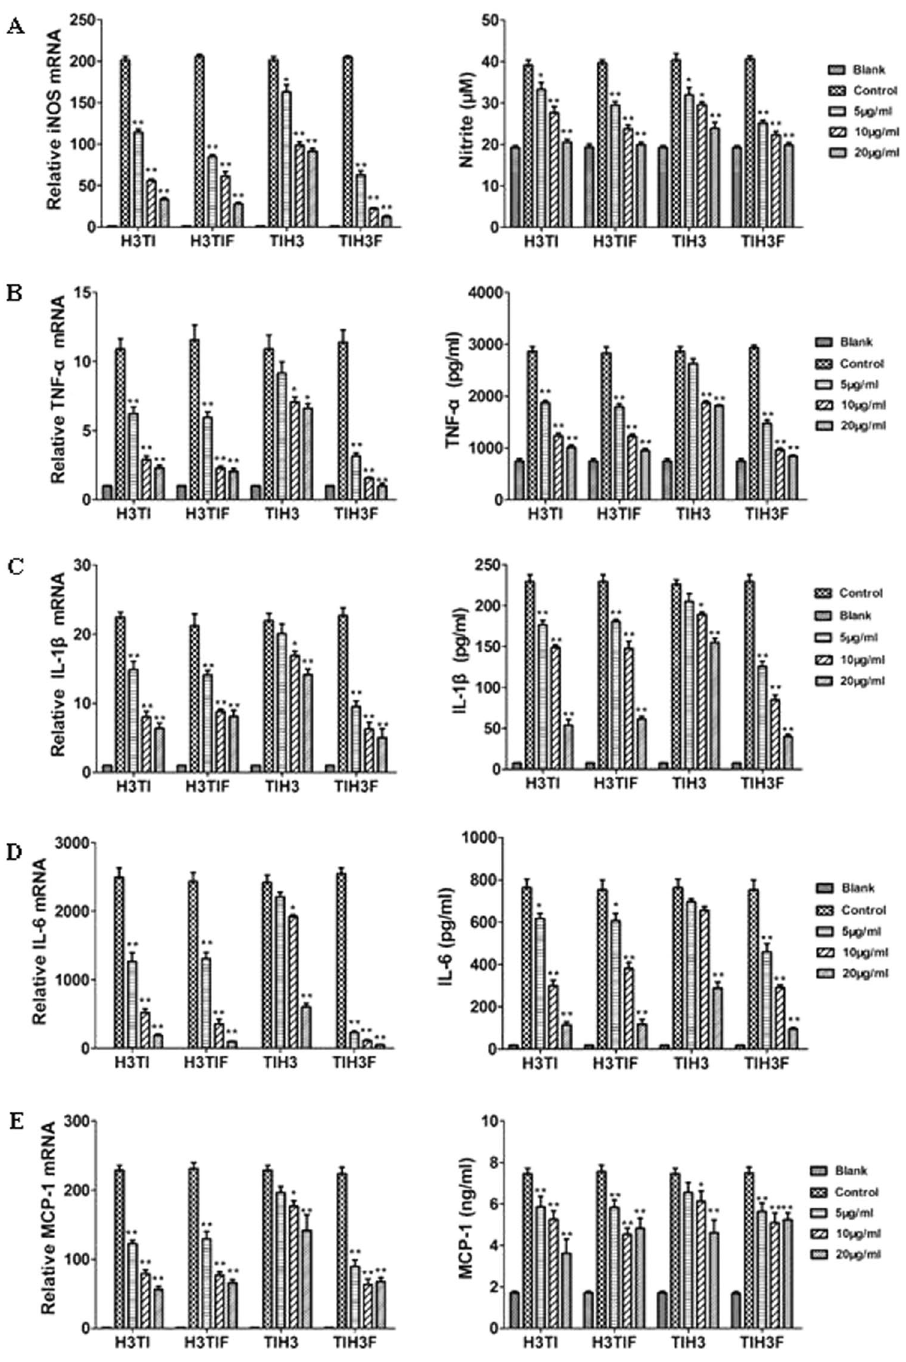
Figure 6. Effects of four hybrid peptides on the inflammatory factors: ( A ) iNOS & nitrite; ( B ) TNF- α ; ( C ) IL-1 β ; ( D ) IL-6; ( E ) MCP-1 transcription and production induced by LPS. Expression of the target genes were measured by q-PCR and normalized against the expression of GAPDH. Target genes expression in untreated cells was normalized to 1. The secretions of NO, cytokines and chemokine in RAW 264.7 culture supernatant were determined by Griess reagent and ELISA, respectively. LPS: 100 ng/mL. Data are mean ± SEM value of three independent experiments ( * P < 0.05; ** P < 0.01; by unpaired t